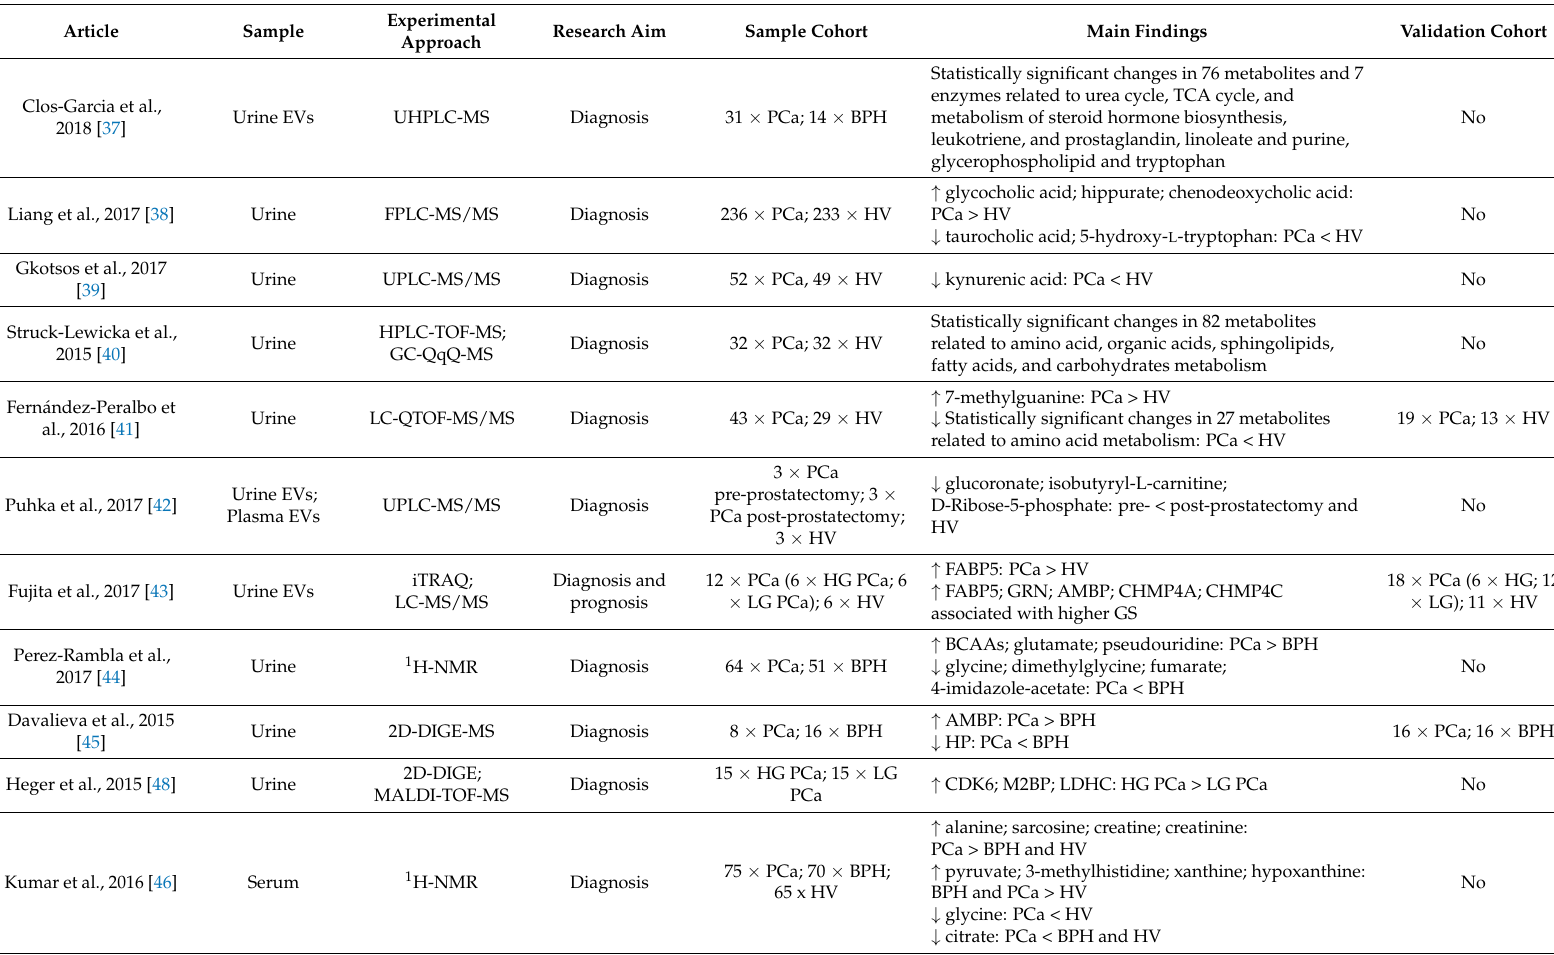
Table 1. Metabolomics studies focused on the analysis of biofluids to identify clinically relevant prostate cancer (PCa)